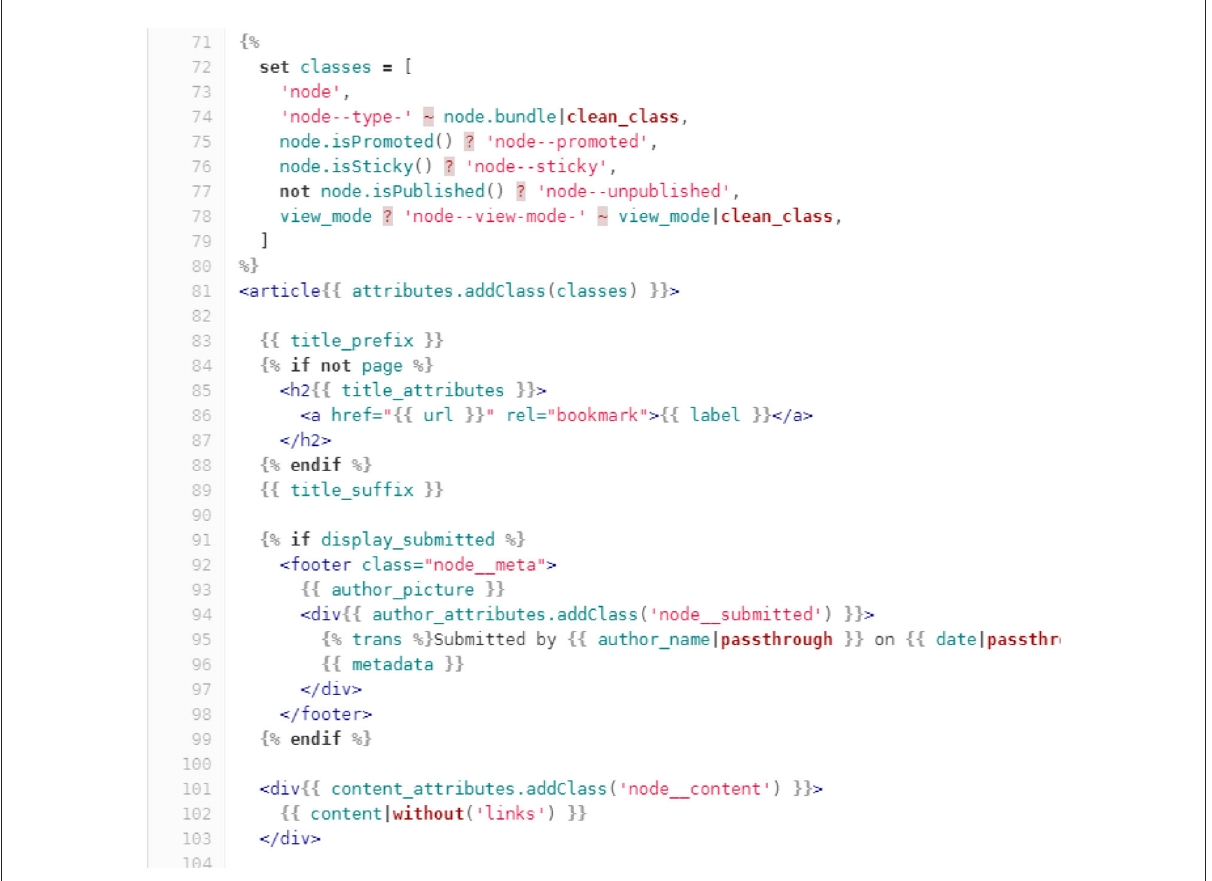
FIGURE3 An example of a Twig representation of